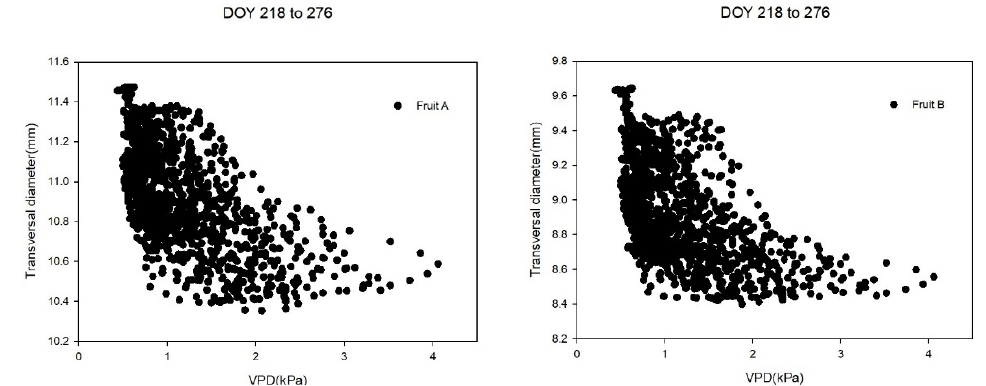
Figure 7. Transversal diameter versus VPD in all days of the first period of the experiment.